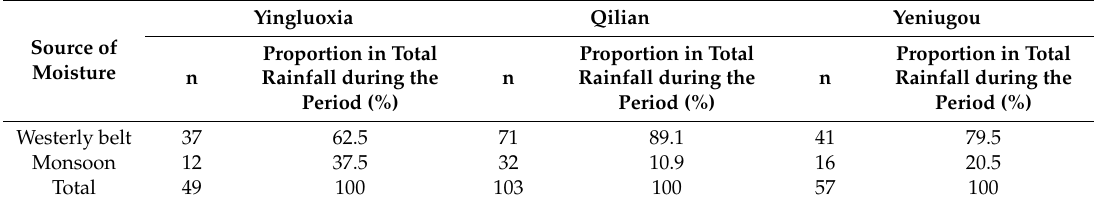
Table 3. Analysis of precipitation from different water vapor sources in the upper reaches of the Heihe River Basin from 2007.10 to 2008.9. The number of precipitation samples from different sources for each site is given in the column labeled “n”.